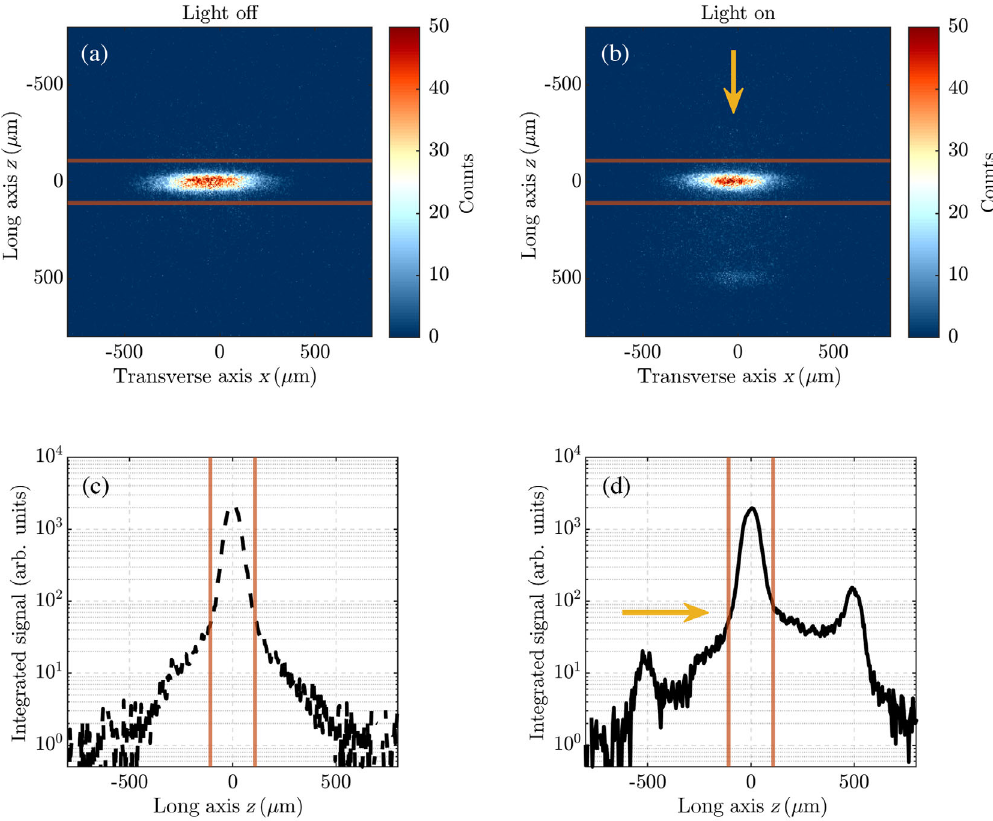
FIG. 9. Region of interests (ROI) for scattering rate measurement. Single-shot image of a 1D BEC after 44 ms time of flight without (a) and with (b) illumination with a 40 - μ s-long laser pulse 500 μ s after trap release. The data are recorded with mean atom number N ¼ 7450 ð 60 Þ , s ¼ 319 ð 11 Þ × 10 − 6 , and Δ ¼ − 392 Γ . The orange lines indicate the ROI for the evaluation of the signal in the atom cloud (cf. Fig. 3). The laser beam is aligned parallel to the axial direction of the initial 1D BEC and indicated by the yellow arrow. (c),(d) Integrated longitudinal profile without (c) and with (d) illumination (logarithmic scale), each averaged over five repeats. Apart from the bulk BEC at z ¼ 0 , two additional side peaks at Δ z ∼ (cid:3) 500 μ m are visible. This is the signal from atoms that have gained a momentum ℏ Δ k ¼ Δ z ð m=t ≈ (cid:3) 2 h= λ ¼ (cid:3) 2 ℏ k λ ≈ 780 nm). The peaks at Δ z ≈ (cid:3) 500 μ m, 0 along z while interacting with the laser beam ( TOF Þ corresponding to Δ k ≈ (cid:3) 2 k 0 , are due to superradiant emission, mostly in the forward direction. For 0 ≤ k ≤ 2 k 0 , the recoil of the atoms due to absorption and spontaneous emission is clearly